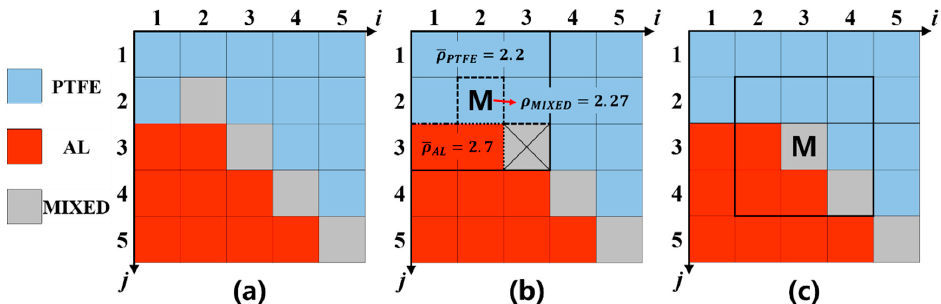
Figure 6. The processing method of the mixed material grids: ( a ) initial grids, ( b ) treatment of mixed material grid (i = 2, j = 2) and ( c ) repeat the treatment for next mixed material grid (i = 3, j = 3).